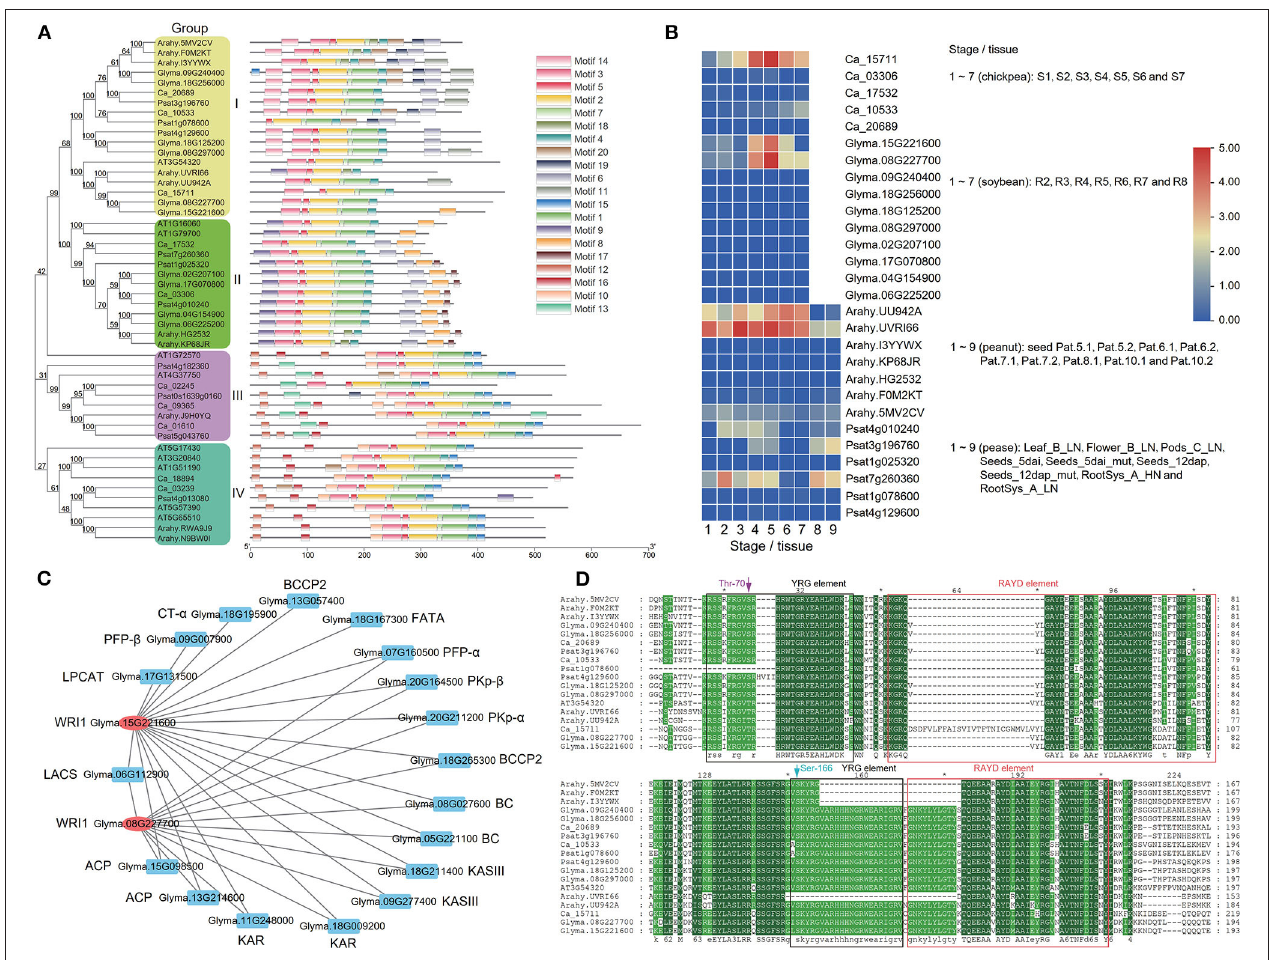
FIGURE 5 | Phylogenetic (A) , expression (B) , co-expression network (C) , and protein sequence (D) analyses of the WRI1 gene family in Arabidopsis (A,D) , soybean (A–D) , chickpea, peanut, and pea (A,B,D) . (C) The genes with blue color are oil synthesis -related genes, while those with red color are WRI1 genes. (D) There are 24 extra amino acids before the VYL motif in the RAYD element in the first AP2 domain of